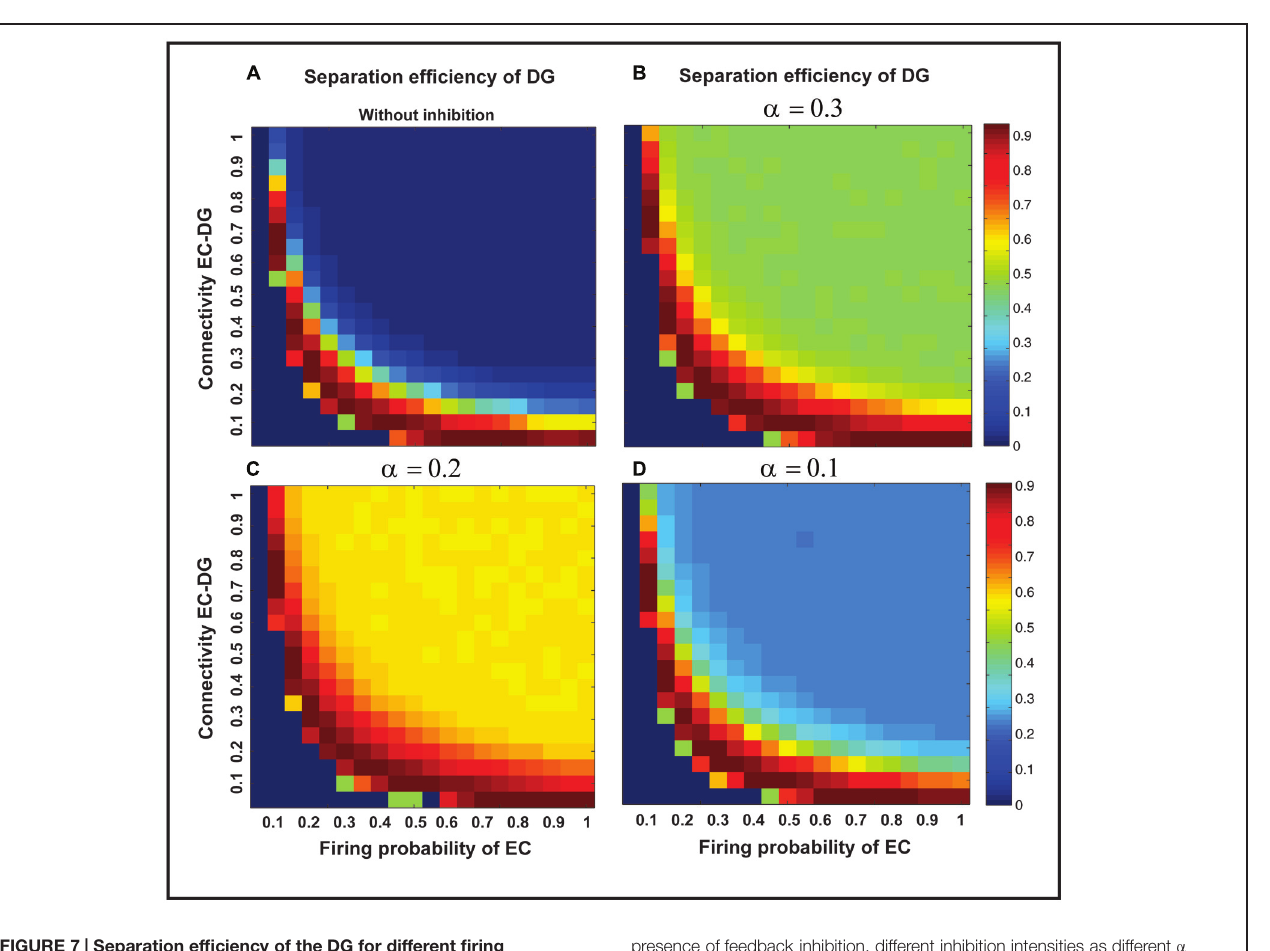
FIGURE 7 | Separation efficiency of the DG for different firing probabilities of activated neurons in the EC, and connectivity rates between the EC and DG. (A) In the absence of feedback inhibition, an increase in connectivity rate leads to a decrease in separation efficiency when incremental firing probability of neurons in the EC is presented. (B) In the